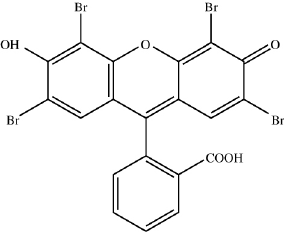
Figure 1: Chemical structure of eosin